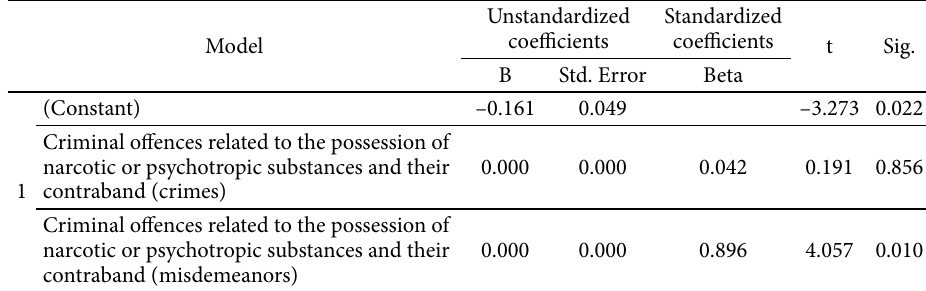
Table 3. Statistics of shadow economy power and criminal offence coefficients in 2005–2012